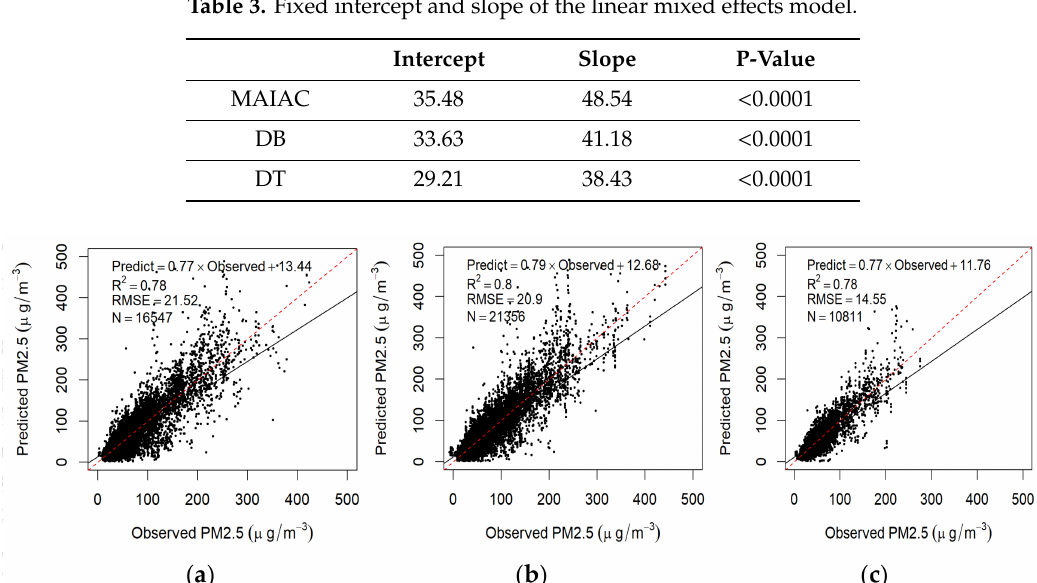
Figure 5. Predicted PM 2.5 vs Observed PM 2.5 for model fitting from MAIAC ( a ), DB ( b ) and DT( c ) AOD.